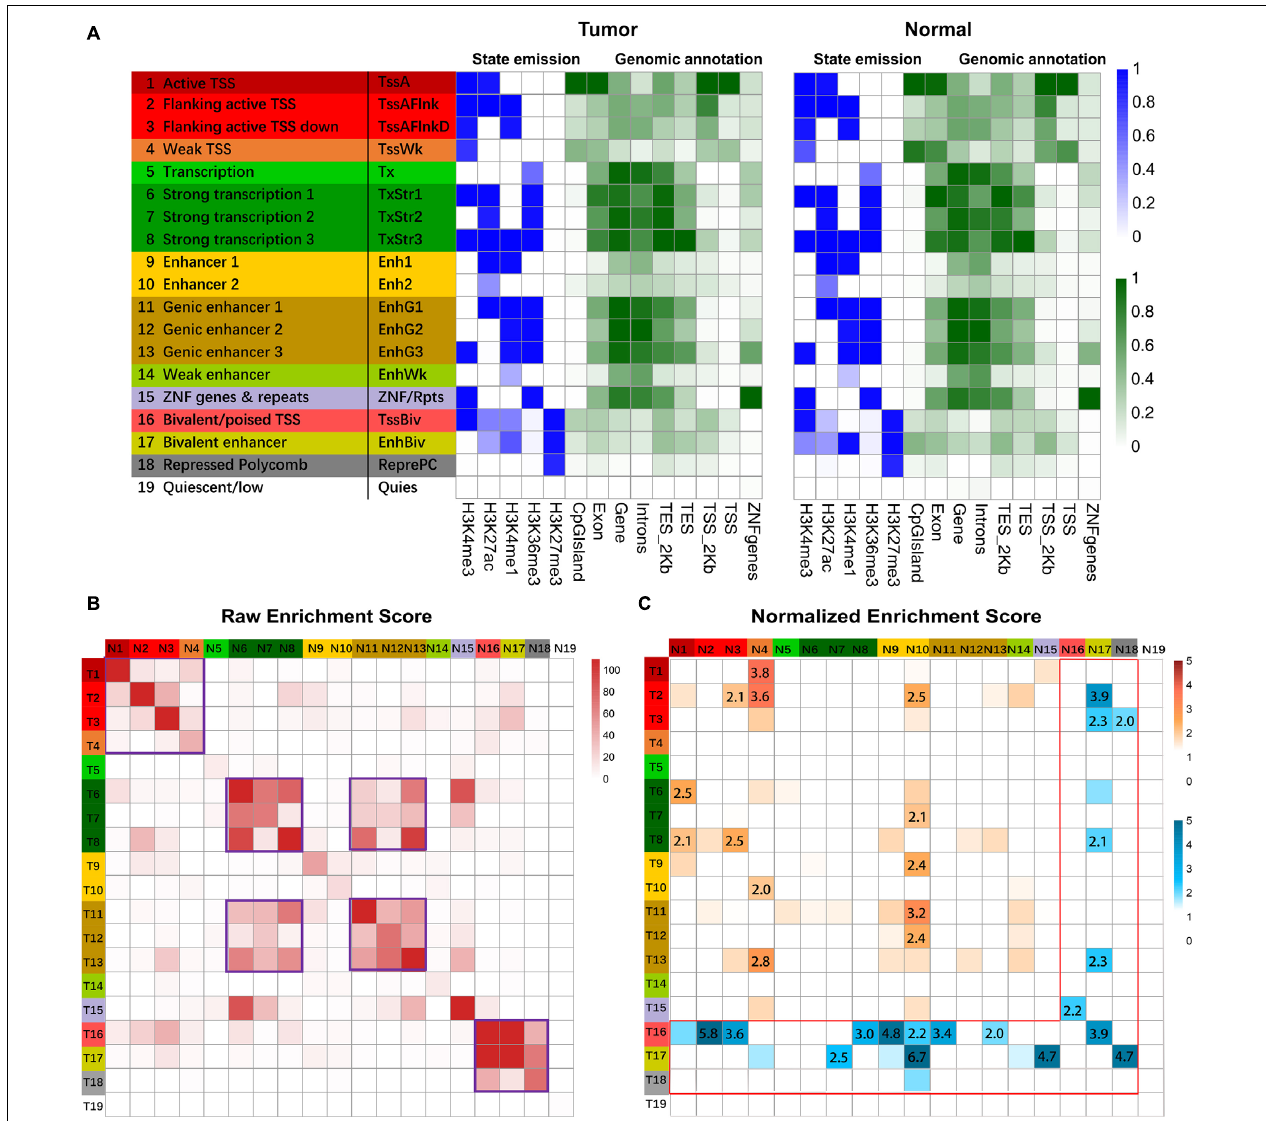
FIGURE 2 | Chromatin state analysis. (A) ChIP signals matrix showed the histone modification profiles of tumor samples and normal samples for the 19 states inferred by the ChromHMM algorithm. First column gave state number and candidate state description, and second column gave the state abbreviations. In the heatmap of the emission parameter, each row corresponded to a different state, and each column corresponded to a different histone mark. The darker blue color corresponded to a higher frequency of occurrence of the mark in the state on the scale from 0 (white) to 1 (blue). The heat map of Genomic annotations displays enrichment for various external genomic annotations. A darker green color corresponded to a higher enrichment on the genomic feature. Overlap of different genomic features (CpG island, Exon, Gene, Intron, TES_2kb, TES, TSS_2kb, TSS, ZNF genes) with chromatin state called in tumor and normal cells. TES indicated transcription end site, and TES_2kb indicated regions within 2kb of the TES. TSS indicated transcription start site, and TSS_2kb indicated regions within 2kb of TSS. (B) Heatmap showed the raw enrichment score of state transitions between normal and tumor samples. The color bars on the left and top corresponded to the color bar of state description in (A) . “T” on left color bar indicated tumor sample, and “N” on the top color bar indicated normal samples. The frequent state transitions were highlighted with purple frame. (C) Heatmap showed normalized enrichment score of transitions of chromatin states from normal to GC samples. The color intensities range from white (relative enrichment < 1) to orange and blue (relative enrichment > 1). The normalized enrichment score of more than two were shown. The region with non-repressive states was labeled with orange color, and the region with the repressive state was labeled with a blue color with red